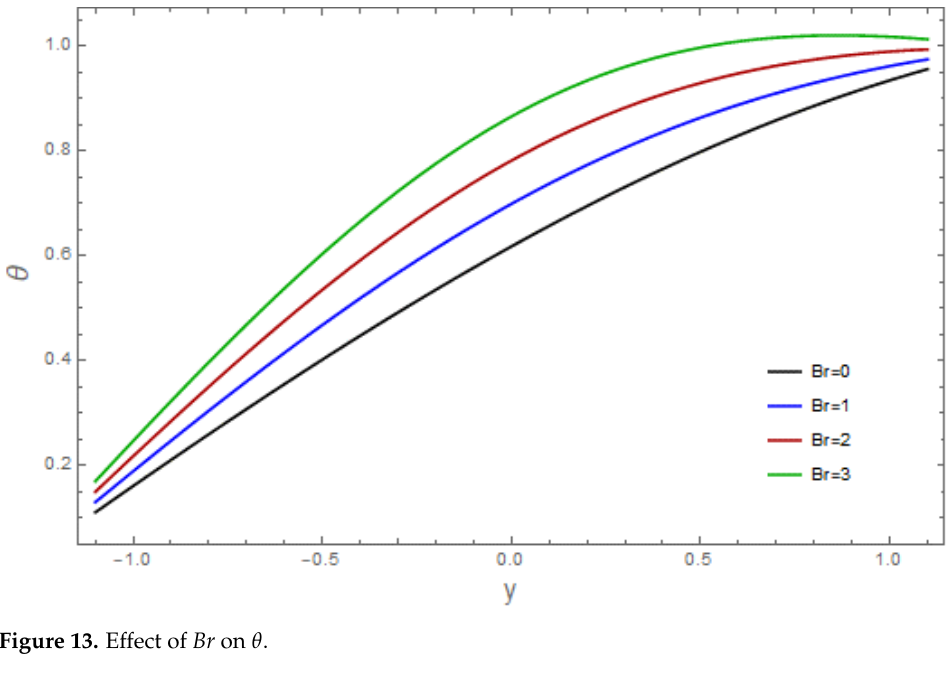
Figure 13. Effect of 𝐵𝑟 on 𝜃 .